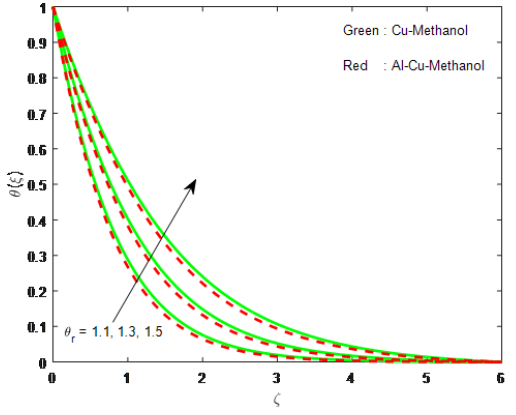
Fig. 23: Impression of θ r on θ ( ξ )